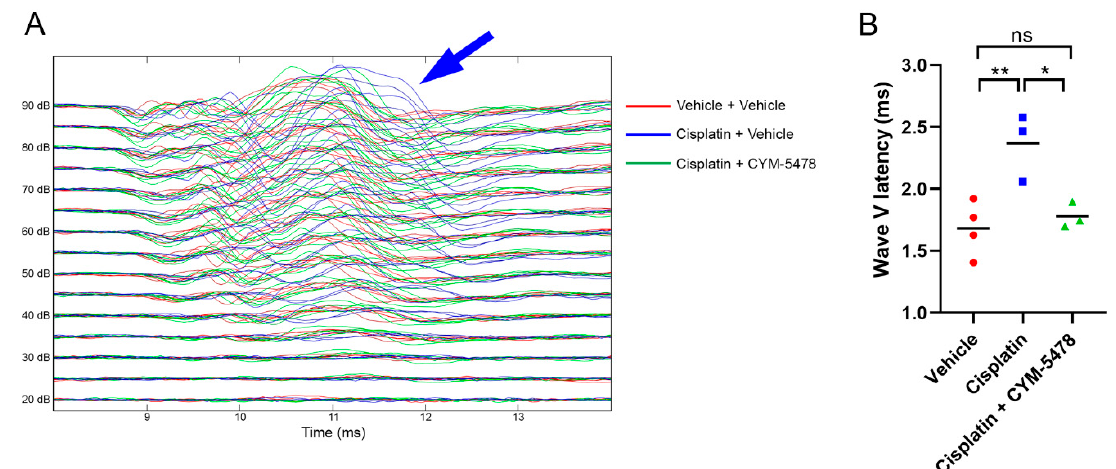
Figure 2. CYM-5478 prevents cisplatin-mediated ABR abnormalities. ( A ) Rats were treated with cisplatin for 3 weeks, with or without co-administration of CYM-5478, before hearing acuity was evaluated by ABR. Although all groups demonstrated similar response thresholds of ~35 dB, the cisplatin-only group exhibited increased waveform latency at all click intensities (arrow). Stimulus onset is at ~7 ms for all groups, including the time taken for sound to reach the ear. ( B ) Quantification of waveform V latency of 90 dB stimuli shown in ( A ). ( n = 3–4, * p < 0.05, ** p < 0.01, ns = not significant.) .